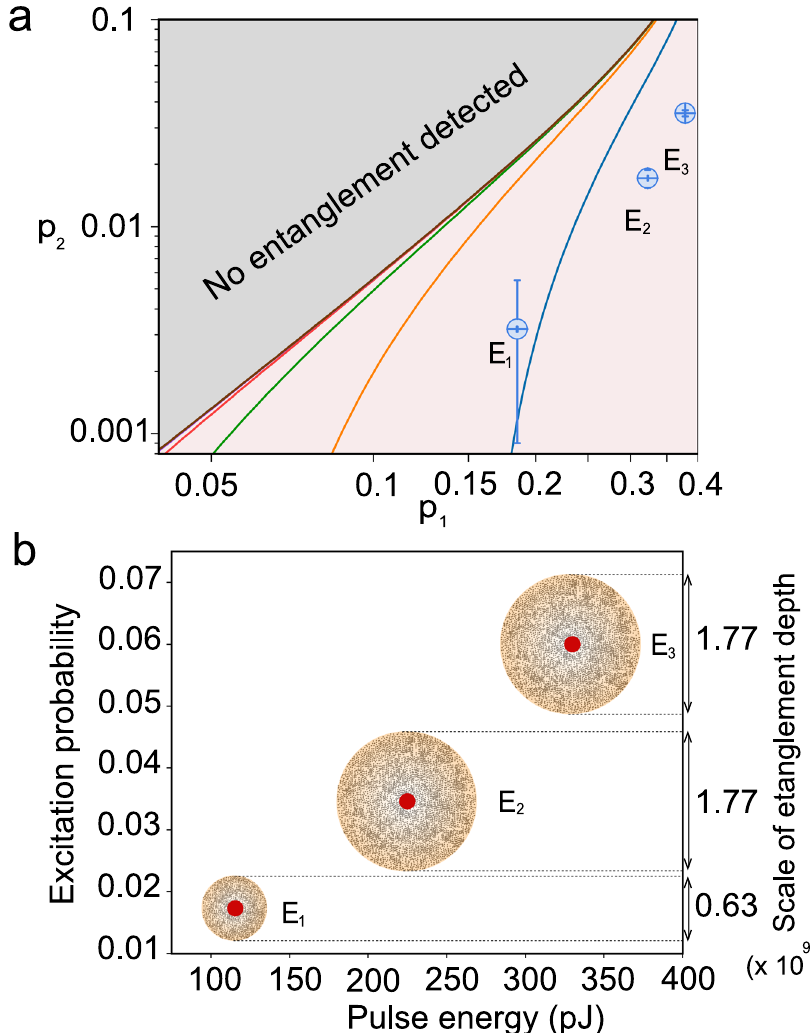
Fig. 4 Measured entanglement depth with different excitation probabilities. a The M values with different excitation probabilities are 14, 5, 5, and the corresponding energy are E 1 = 115.5 pJ, E 2 = 225 pJ, E 3 = 330 pJ. The uncertainty for the M value of E 1 is mainly derived from the error bar of p 2 with the upper bound of 15 and the lower bound of 10. The time interval between creation and veri fi cation light pulse is 30 ns. Error bars are derived by the Poisson distribution of photon number statistics from avalanche photodiodes. b The visualized entanglement depth for comparison with different excitation probabilities. The red dots represent the relations of the excitation probability and pulse energy, and the size of the circle taking the red dot as center stands for the scale of entanglement depth. According to the aforementioned de fi nition of entanglement depth, it determines the smallest number of genuinely entangled particles among the M subgroups, which only delivers a lower bound of the genuine entanglement scale. Thus, it is reasonable that the same lower bound of entanglement depth is observed with different excitation